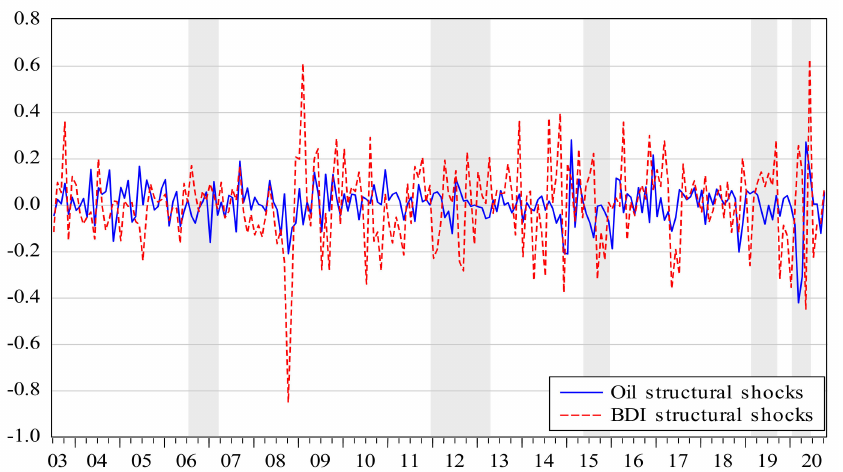
Figure 3. Dynamic characteristics identification of oil commodity attribute. Note: There is a negative relationship between the demand and the structural impact of crude oil price shown in shadow parts.